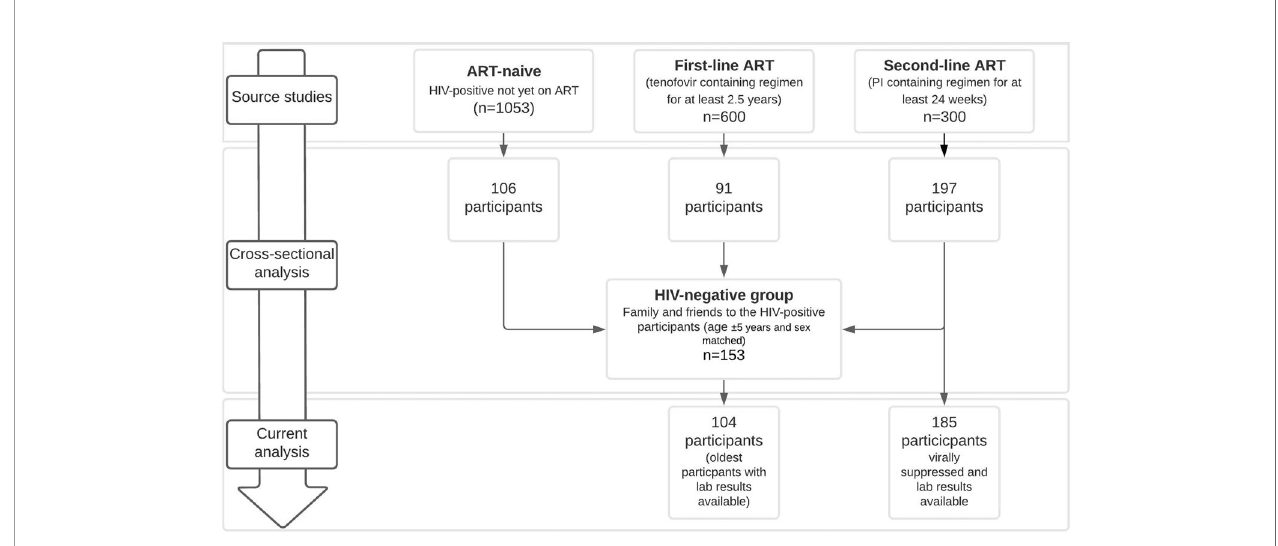
FIGURE 1 | Participant